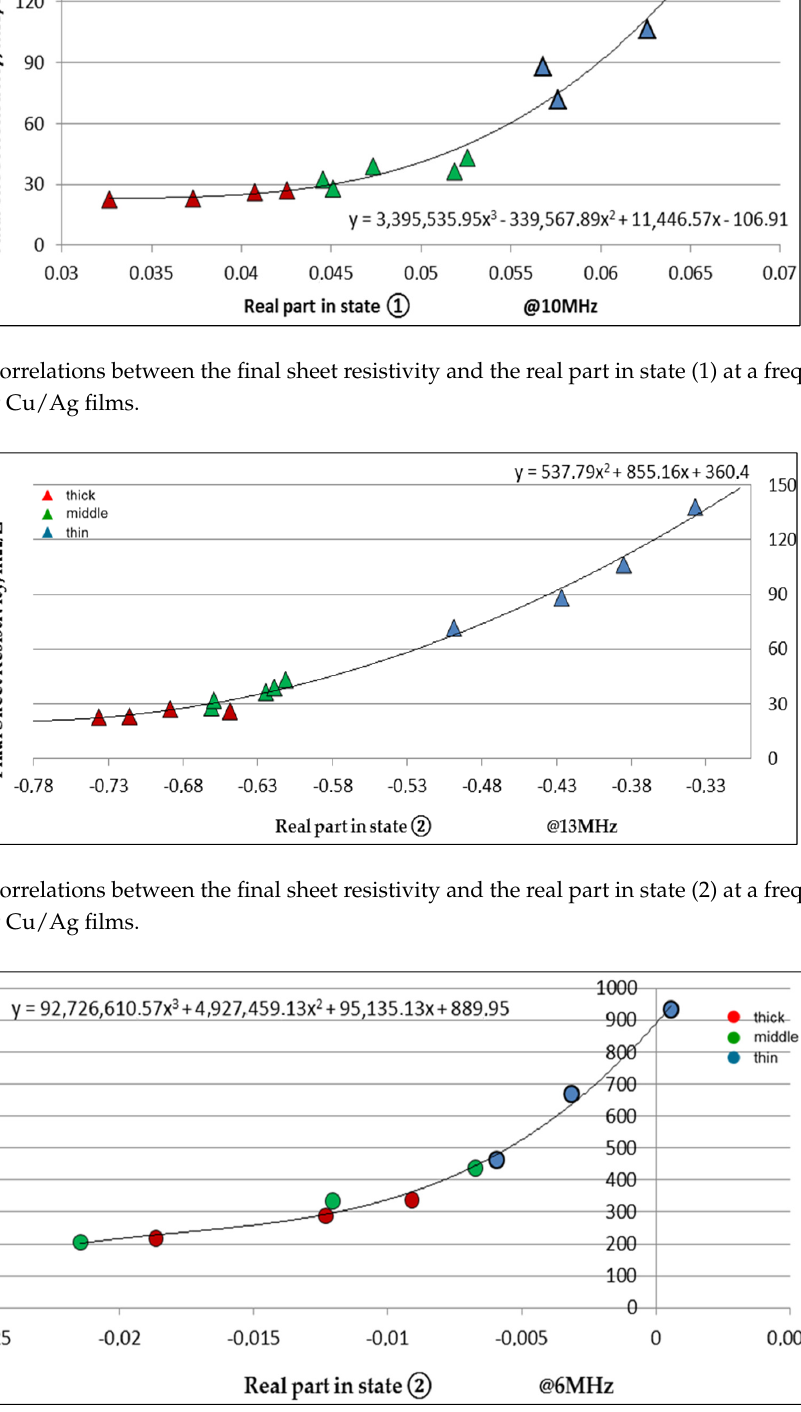
Figure 10. Correlations between the final sheet resistivity and the real part in state (2) at a frequency of 6 MHz for glass/Ag films.